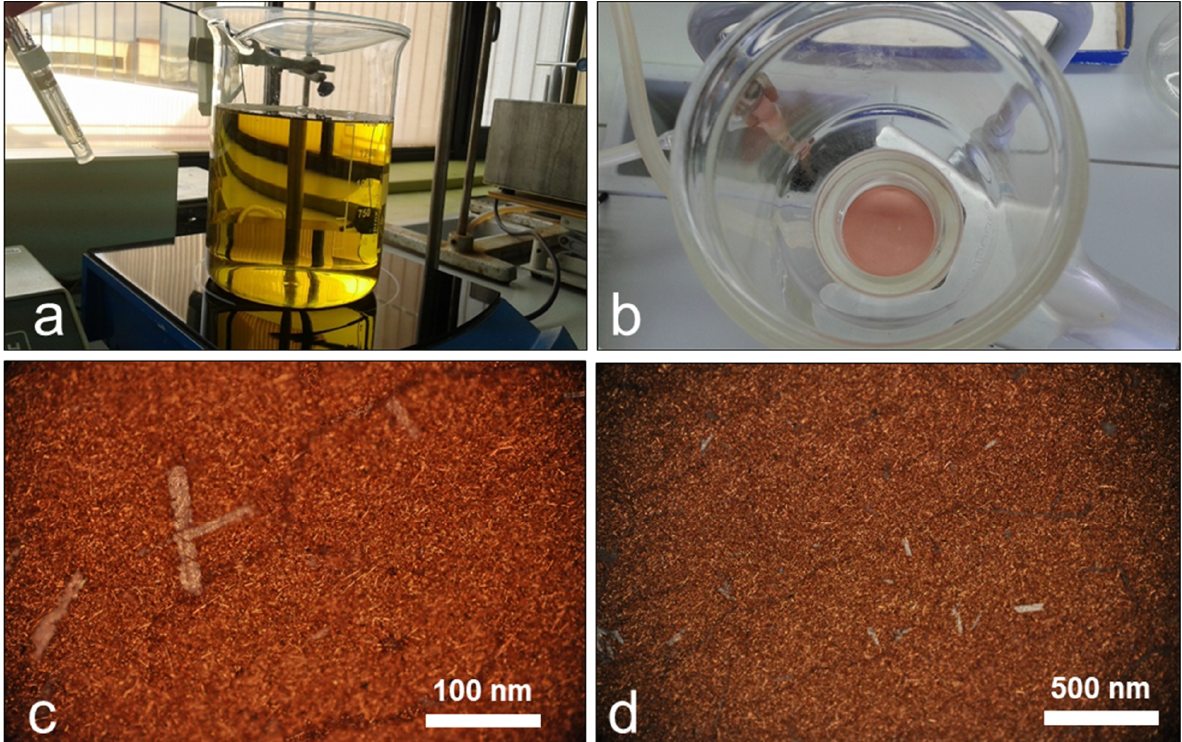
Figure 1. ( a ) Natural Cu-rich aqueous solution from AMD-affected acidic stream mixed with 10 mM AA (pH = 3.95, T = 25 °C) and containing an undetermined transient Cu complex; ( b ) Metallic copper precipitate formed on the filter after filtration of the solution shown in ( a ) after 24 h; ( c , d ) Reflected light microscope photomicrographs (at 500 × magnification) taken on the filter shown in ( b ), showing a network of small acicular microcrystals of metallic copper (Cu[0]) along with sparse large translucent crystals of gypsum which could not be avoided (due to high Ca and SO 4 concentration in the AMD waters).